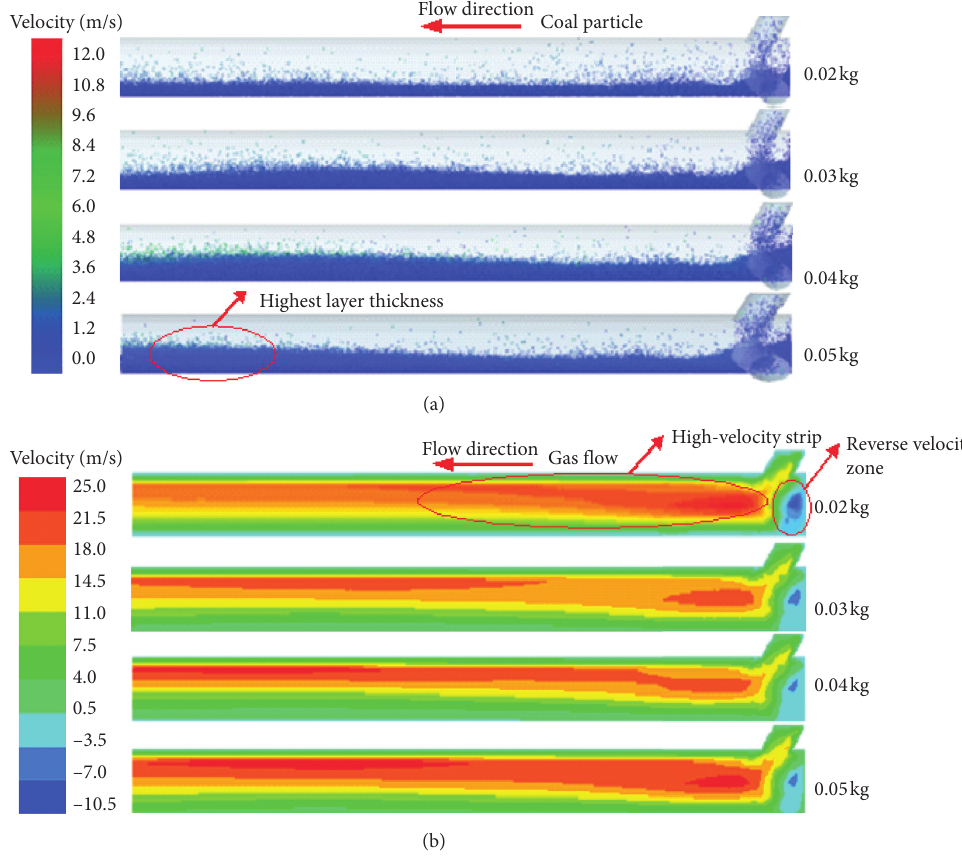
Figure 4: The coal-gas flow characteristic in drilling bit-rod integral structure 0 ∼ 0.5m under gas velocity of 15 m/s ( t � 3